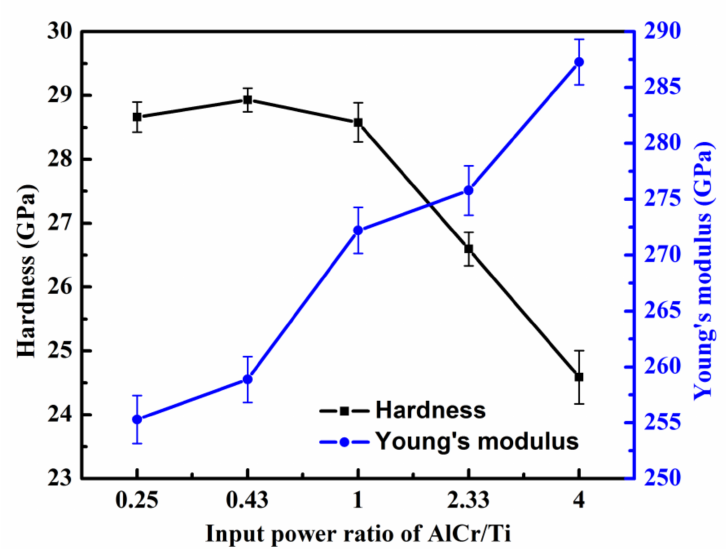
Figure 8. The hardness (black line) and Young’s modulus (blue line) of the AlTiCrN coatings deposited under various input power ratios of the AlCr/Ti target.